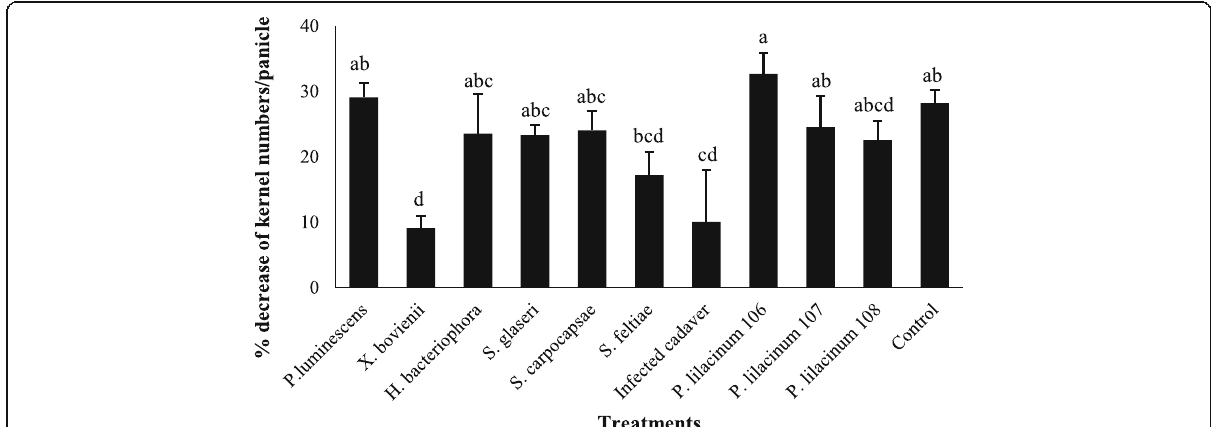
Fig. 3 The effect of treatments on the average decrease of kernel numbers (%) in the panicles. Differences were significant at P < 0.05, and the same letters are not significantly